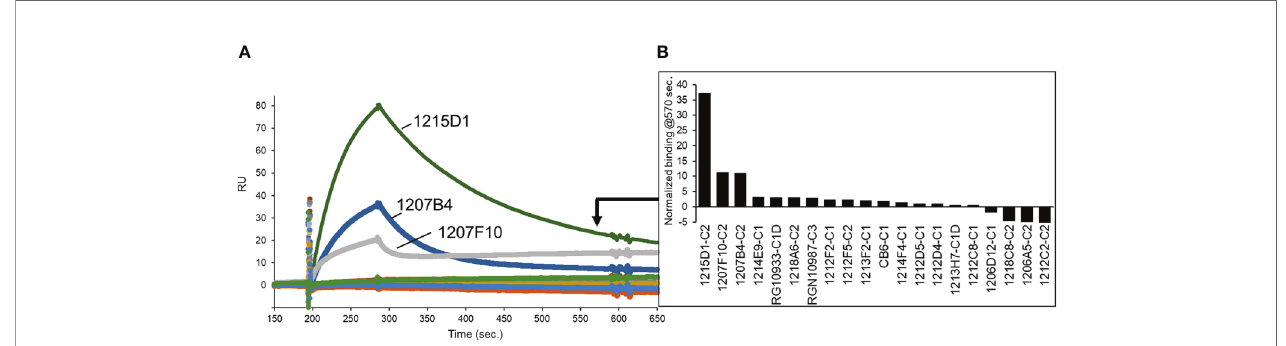
FIGURE 8 | NAb epitope analysis using a SARS-CoV-2 RBD-ACE2 fusion protein. (A) NAbs were captured on anti-IgG biacore chips and sensorgrams were recorded for an RBD-ACE2 fusion protein (20nM) injected over the surface of each NAb. (B) Variability in fusion protein binding levels near the end of the sensorgrams (t = 570 seconds) is plotted in